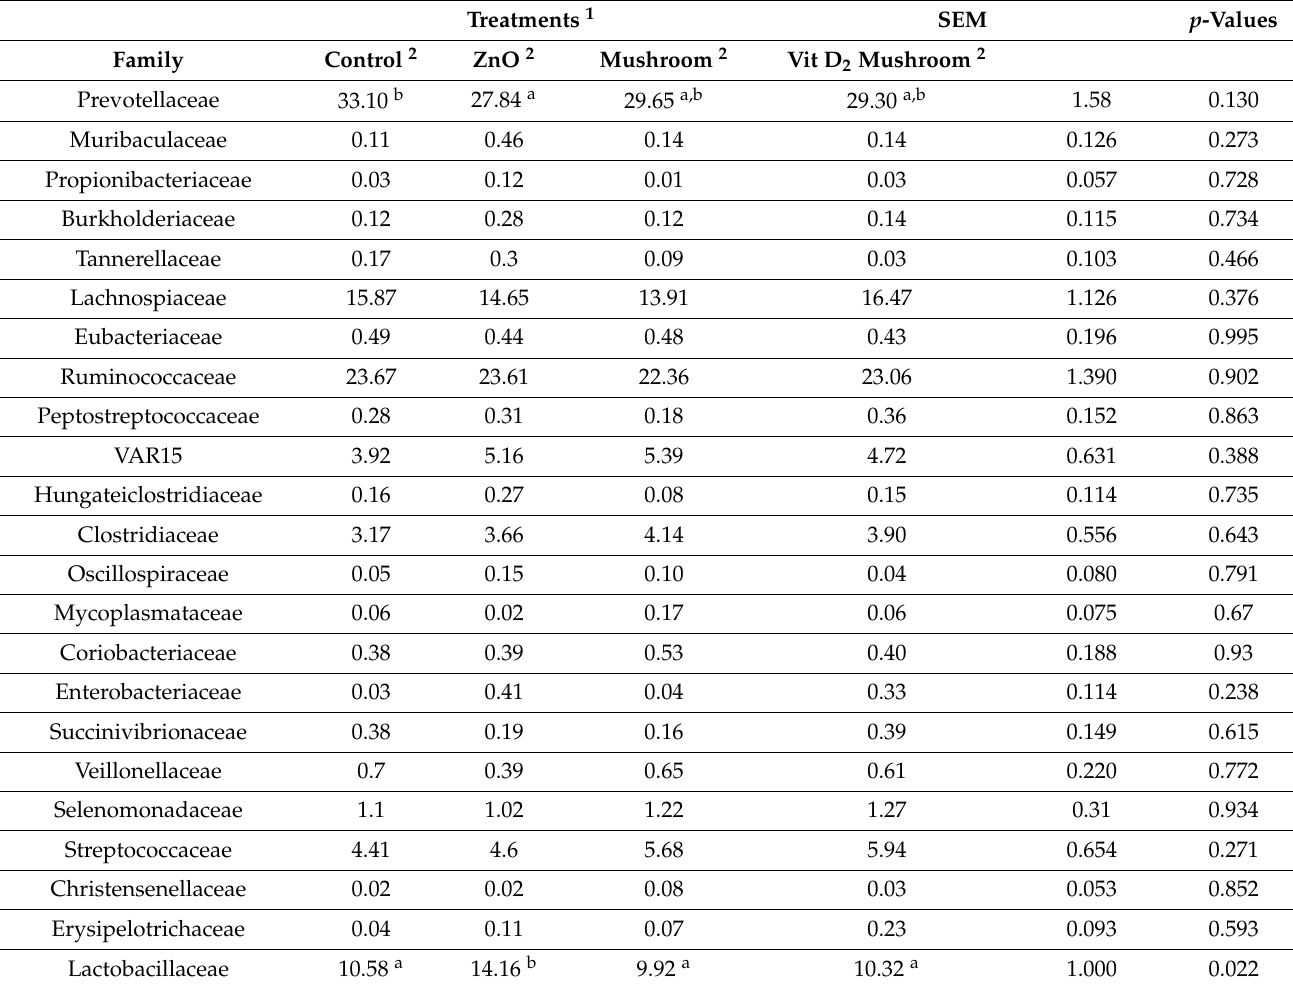
Table 7. The effect of dietary treatment on the % bacterial abundance at family level (Least-square means with their standard errors).